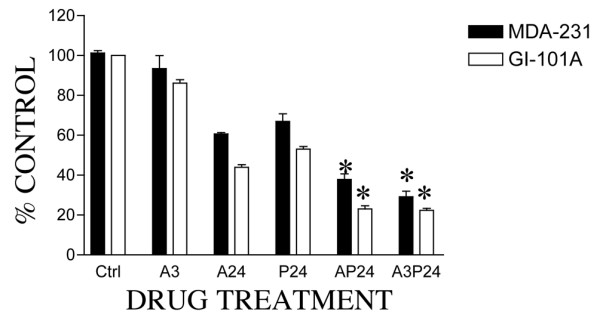
Combination and sequential exposure of cells to PRIMA-1 and adriamycin. Exponentially growing MDA-MB-231 or GI-101A cells were seeded in 10% serum-supplemented RPMI-1640 medium at 104 cells per well. After 24 hours, cells were treated with 100 μM PRIMA-1 for 24 hours (P24), 0.2 μM adriamycin for 3 hours (A3) or 24 hours (A24), and a combination of PRIMA-1 plus adriamycin for 24 hours (AP24) or adriamycin for 3 hours followed by PRIMA-1 for 24 hours (A3P24). After drug treatment, the cells were reincubated in drug-free medium for a further 3 days and cell survival was determined with the crystal violet assay. Results are means ± SD for quadruplicate determinations (SD<10%) representative of two to four independent experiments; P<0.01.